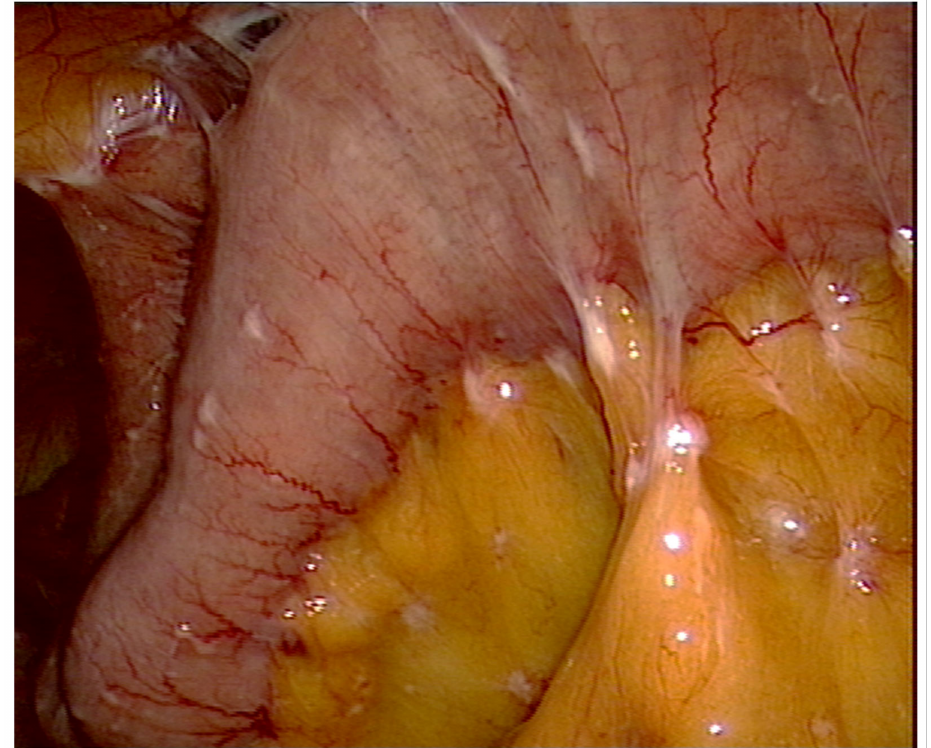
Figure 1. Laparoscopy demonstrating a small bowel disease with mesenteric nodules in a patient with gastric cancer. This situation cannot be treated effectively with CRS and